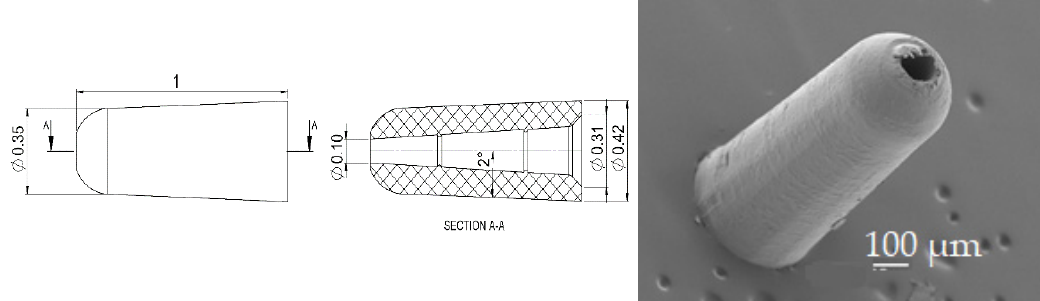
Figure 3. Design specifications of the polymer micro-cap in the analysis ( left and center ); scanning electron microscope image of the micro-injection molded part ( right ) [31].